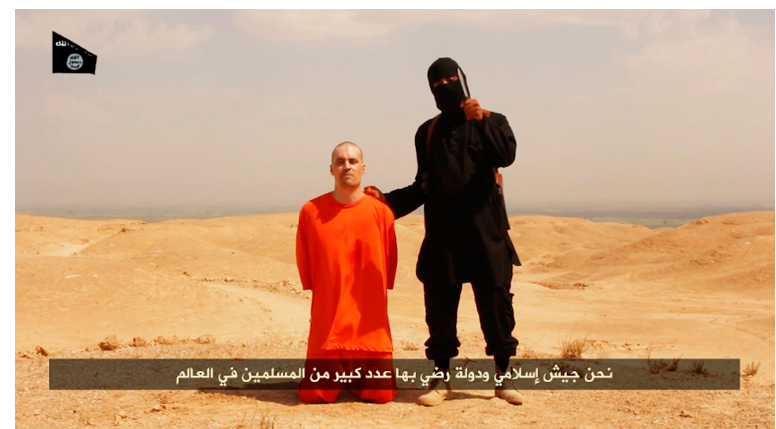
Figure 6. Frame from the ISIS-made video documenting the execution of the American journalist James Foley (August 2014). (Available at: http://www.ilfattoquotidiano.it/2014/08/20/siria-isis-pubblica video-decapitazione-di-un-giornalista-usa-rapito-nel-2012/1094477/, last accessed: 21 August